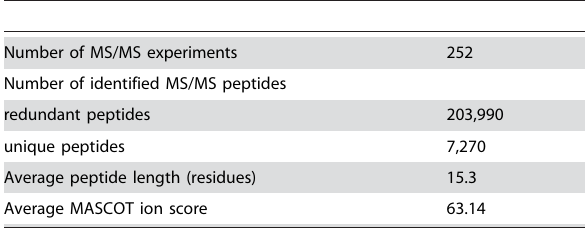
Table 1. Number, average length, and average MASCOT score for all peptides identified by MASCOT when the MS results were searched against the amino acid sequences in the combined